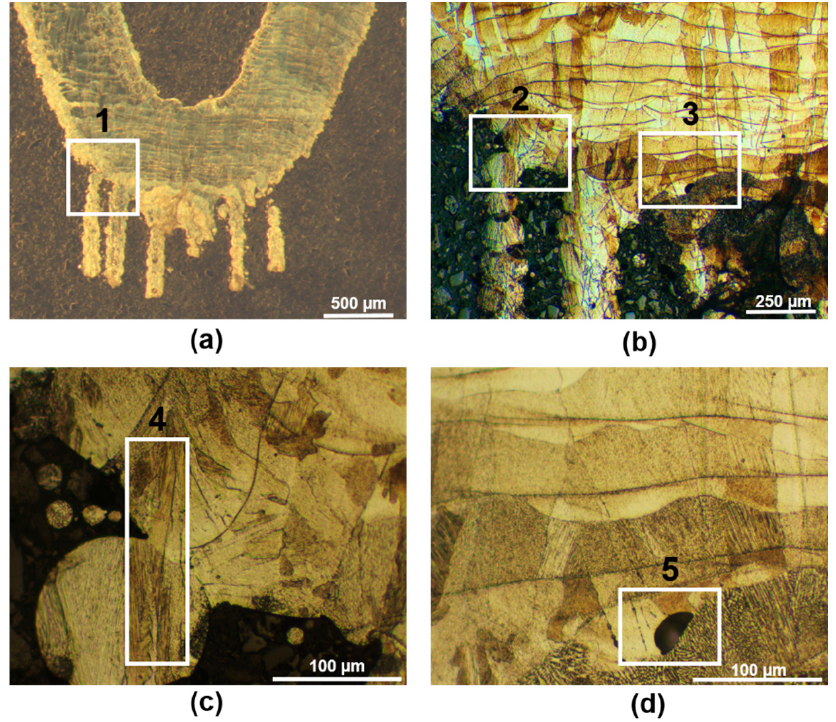
Figure 10. Light microscopy images taken at different magnifications representing the boundary between support and specimen for ( a ) cross support with ( b ) two regions highlighted, and these are shown in detail in ( c , d ) .